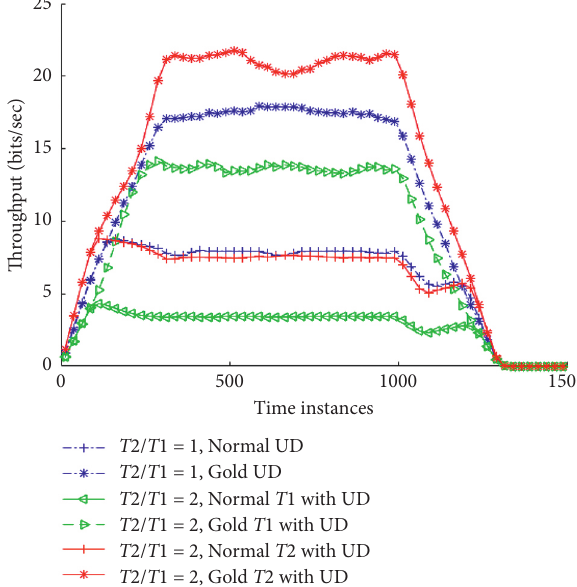
Figure 6: Mean load history of all users with 10% gold